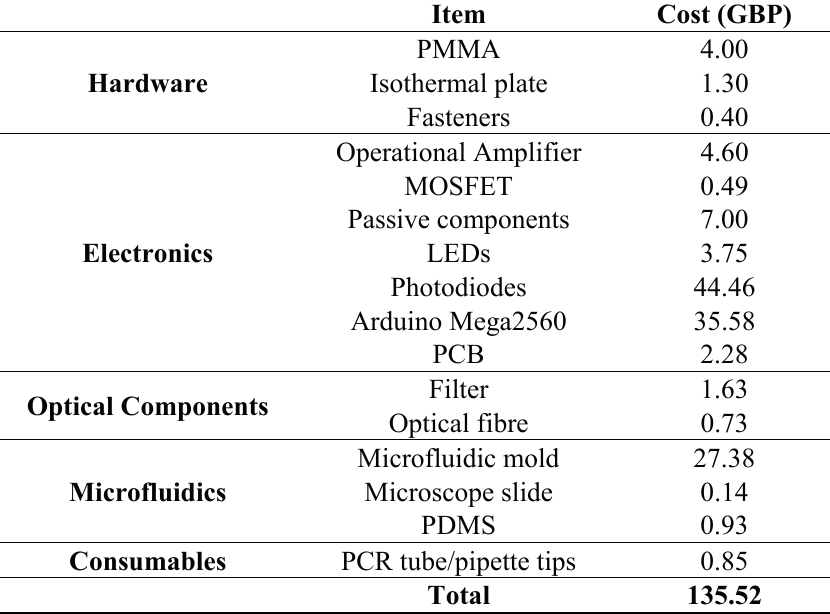
Table 1. Bill of materials for the device and microfluidic cartridges. A large portion of